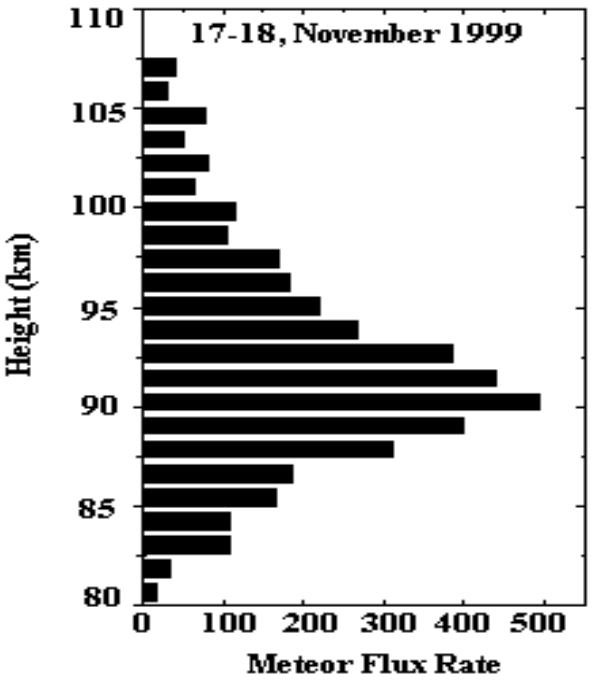
Fig. 3. The altitude distribution of meteor recorded on 17–18 No- vember 1999.